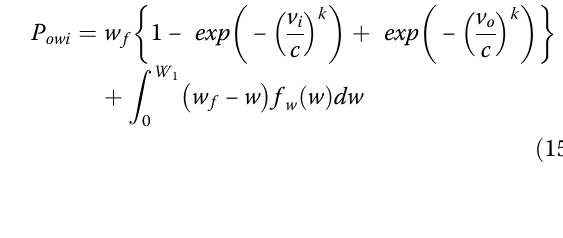
Table 16 Simulation results on the IEEE 30 bus system with DG injection using different algorithms